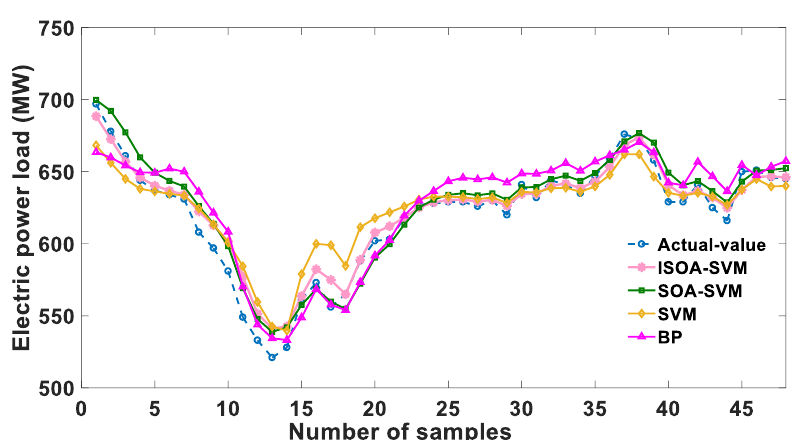
Figure 5. Power load forecasting results of four models for Case 2.